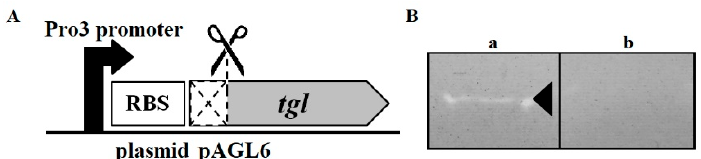
Figure 4. S. aureus cell wall-degrading activity of Tgl protein. ( A ) Schematic picture of expression cassette of pAGL6 plasmid encoding recombinant version of Tgl (Tgl ∆ SP) protein deprived of signal peptide. ( B ) Zymograms obtained upon separation of pellet proteins of E. coli BL21 cells harboring plasmid pAGL6 (a) or pMLE5 (empty control vector) (b), by SDS-PAGE in gel containing dead S. aureus cells. Band of clearing that was detected upon protein renaturation in the gel (see Materials and Methods), is indicated by arrowhead.